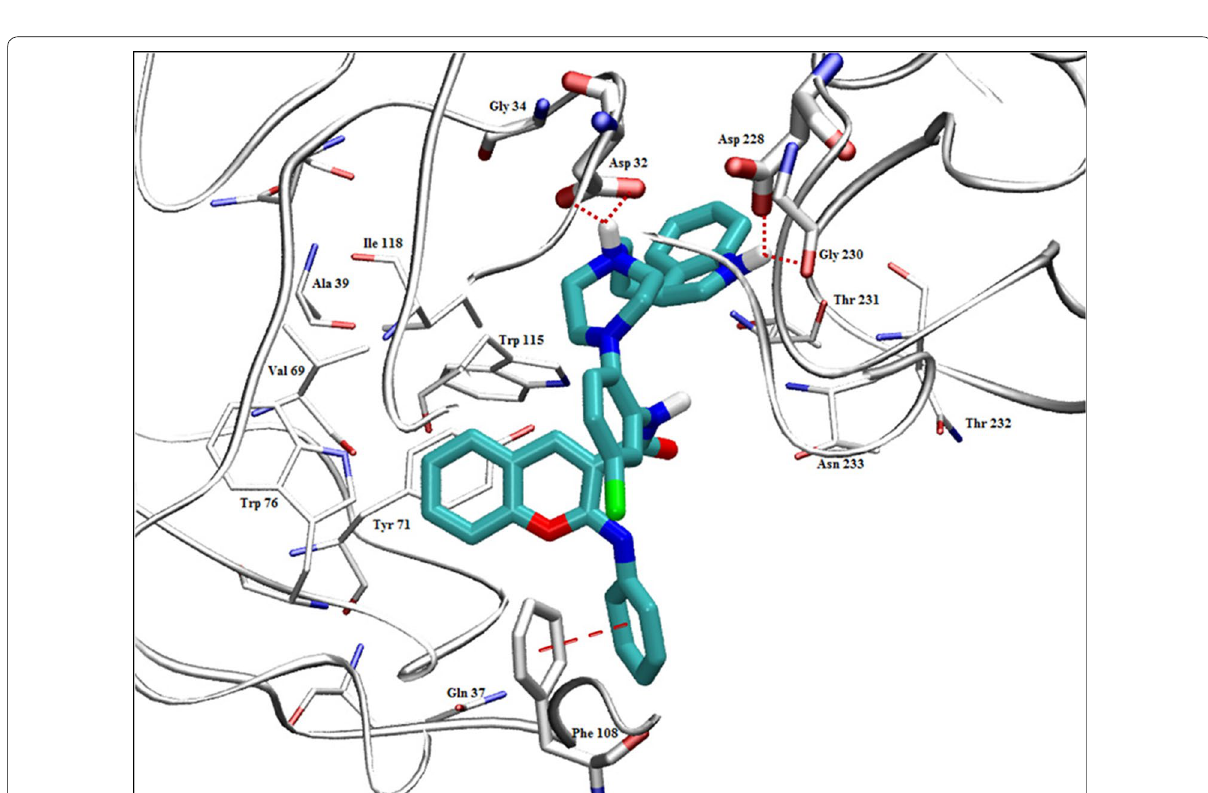
Fig. 78 Binding mode of C91h into active site of BACE1